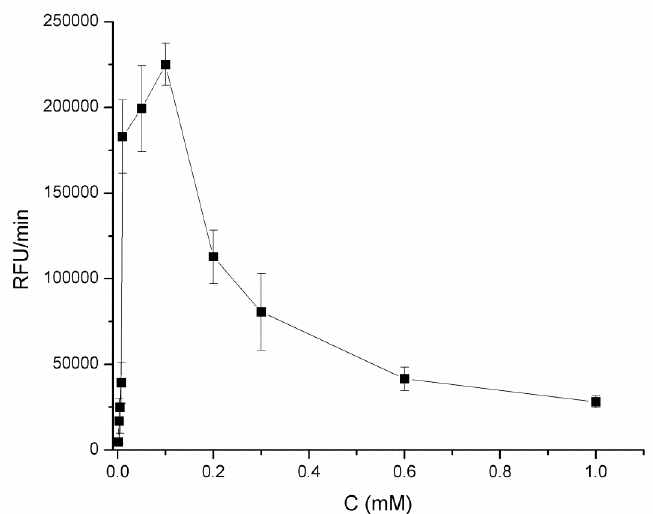
Figure 2. Dependence of fluorescence signal (RFU/min) on resazurin concentration in 0.1 M sodium phosphate buffer pH 5.5 with 10 mM lactose and 0.29 IU/mL of CDH enzyme. Fluorescence measured at ex/em 540/590 nm.